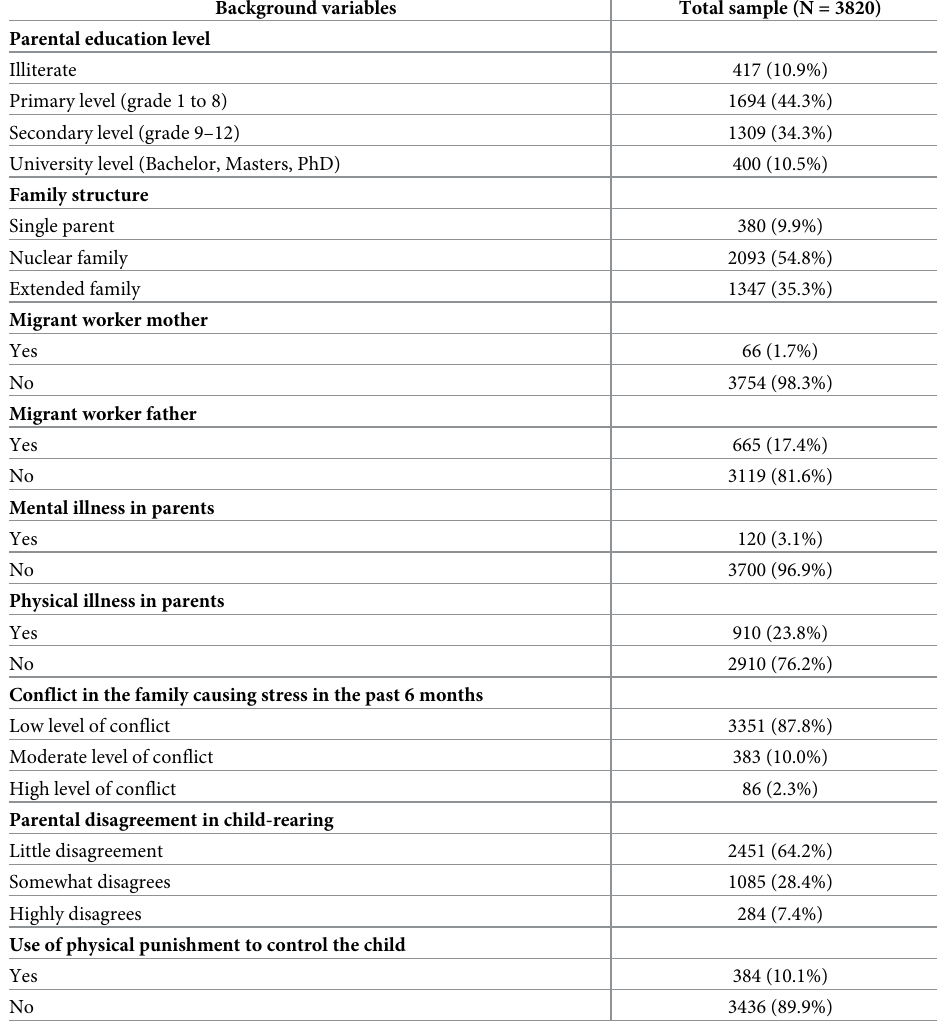
Table 1. Background table. Distribution of family